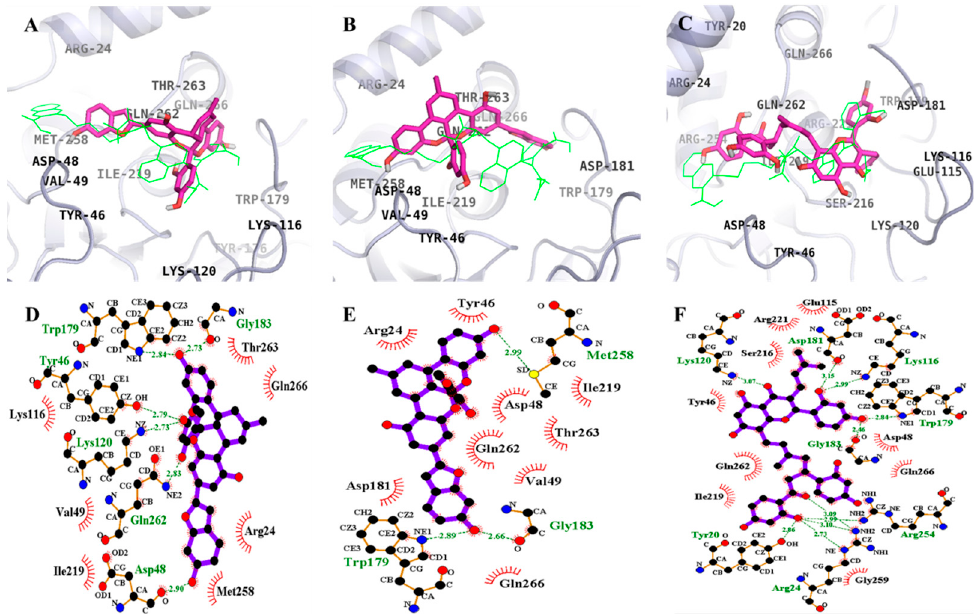
Figure 3. Molecular docking models for PTP1B inhibition at catalytic site by 1 – 3 along with reported inhibitor compound 23 (green line). 1 ( A ); 2 ( B ); and 3 ( C ). 2D ligand interaction diagram of PTP1B inhibition by 1 ( D ); 2 ( E ); and 3 ( F ). Schematic representation of interaction between ligands 1 – 3 and the PTP1B, thick purple stick models present the compounds 1 – 3 , green dotted lines are hydrogen bonds, and dashed half-moons present hydrophobic interactions with the corresponding amino acid residues of the